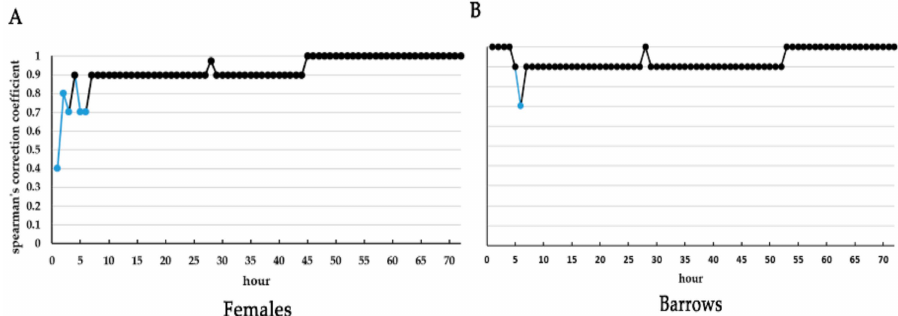
Figure 6. Correlation coe ffi cients between Glicko ratings at each hour and Glicko rating at 72 h post mixing for the first ranked females ( A ) and barrows ( B ). Blue colors indicate there is no correlation of Glicko ratings between the present hour and 72 h post mixing ( p > 0.05); Black colors indicate there is a significant correlation of Glicko ratings between the present hour and 72 h post mixing ( p < 0.05). Y-axis representing the Spearman’s ranks correlation coe ffi cient of Glicko ratings between the present hour and 72 h post